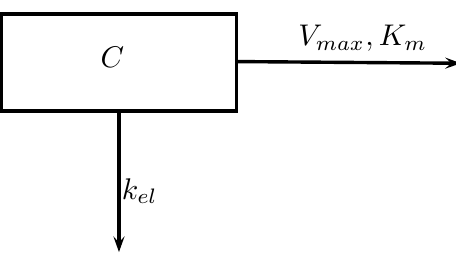
Figure 2. Schematic representation of I.V. bolus injection with mixed drug